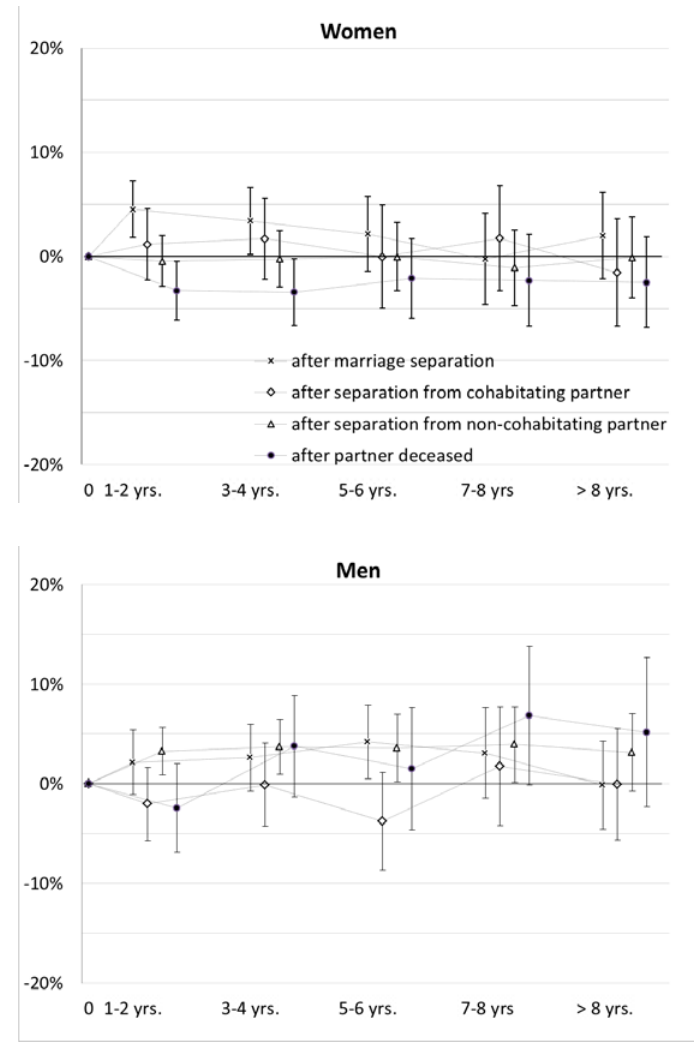
Figure 3 : Time-effects of relationship endings on social isolation (linear-probability models with fixed effects, percentage points and 95%-confidence limits)